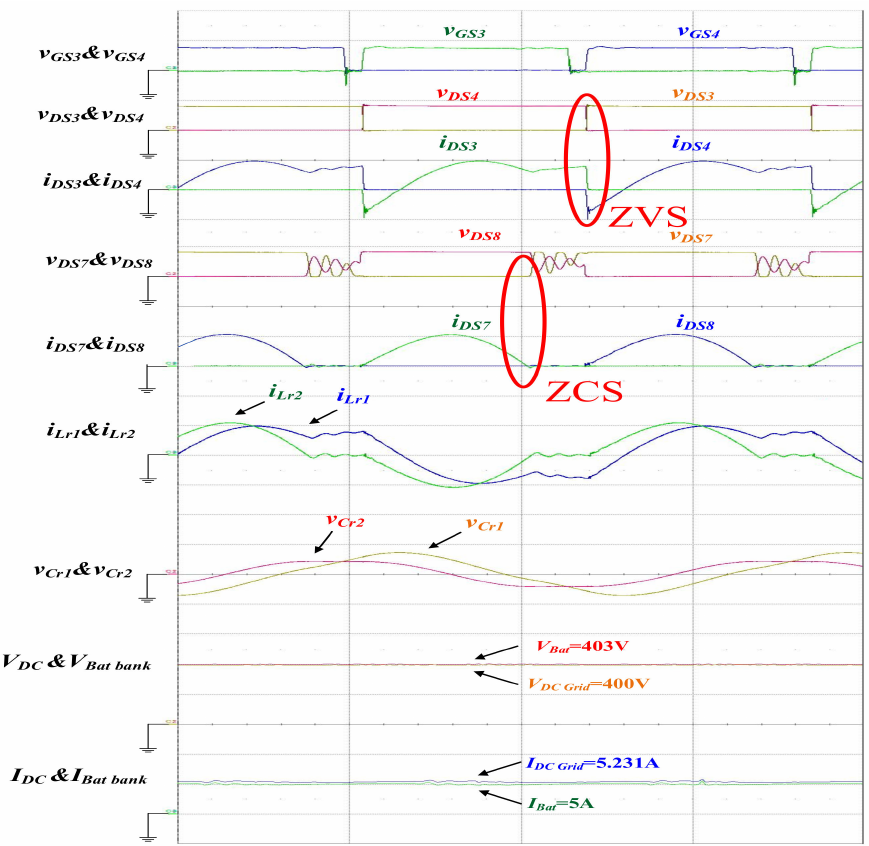
Figure 17. Waveforms obtained when the output battery voltage, V Bat bank , was 403 V and the fabricated converter was operated at full load ( v GS 3&4 : 20 V/div; v DS 3&4 , V DC , V Bat bank : 200 V/div;